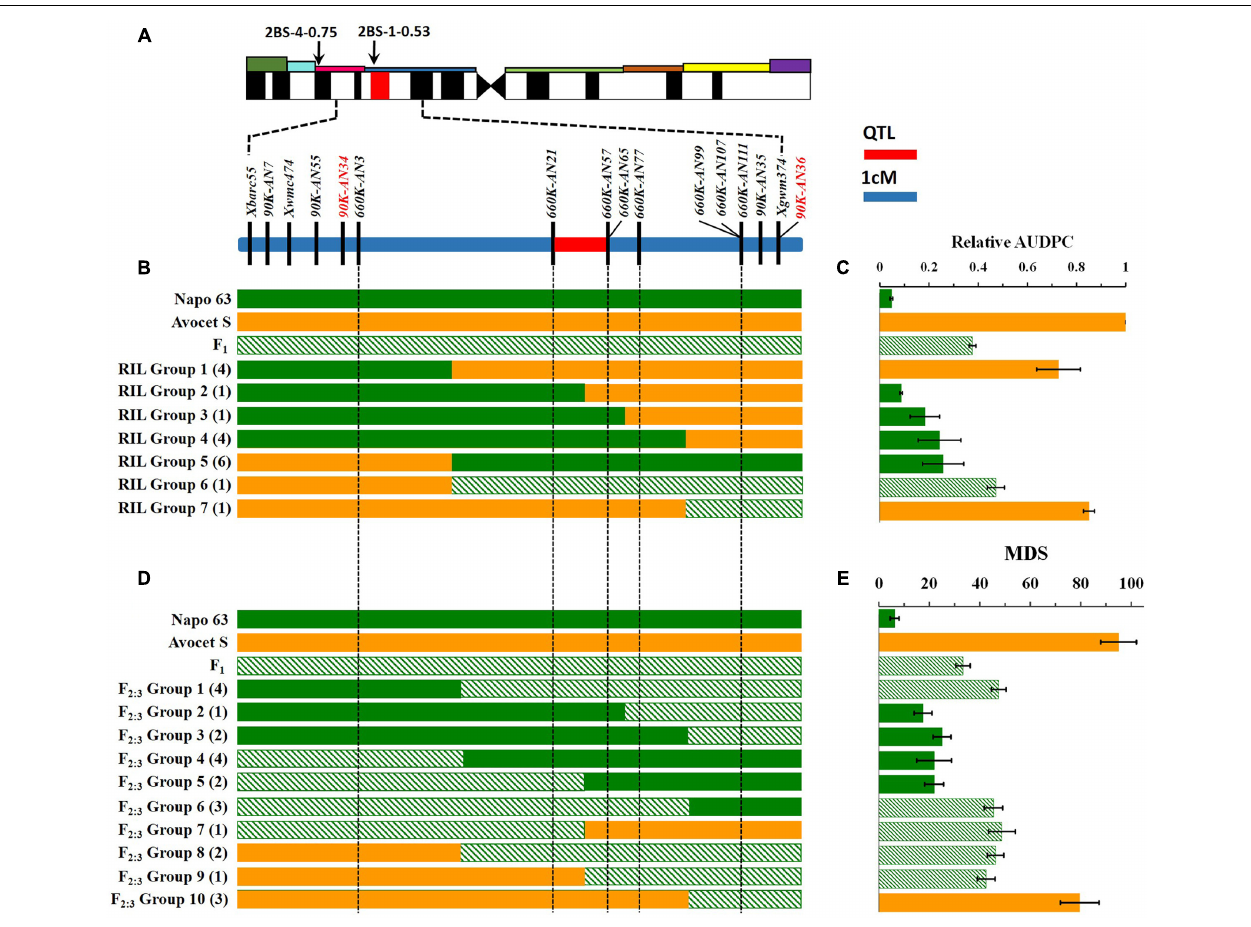
FIGURE 3 | Interval mapping of the QTL region for Qyrnap.nwafu-2BS and association with phenotype. (A) Deletion bin location of Qyrnap.nwafu-2BS in 2BS indicated by SSR markers and linkage map of SNP and SSR markers across the Qyrnap.nwafu-2BS interval. (B) The graphical genotype of in Avocet S × Napo 63 RILs and (D) F 2 : 3 lines are aligned against their response to stripe rust ( C,E , respectively). Recombinants are grouped by adjacent markers, and numbers of lines in each group are indicated in parentheses. Green, orange and slash bars represent homozygous resistant (Napo 63), homozygous susceptible (Avocet S) and heterozygous resistant (F 1 ) genotypes, respectively. Response groups are differentiated as susceptible (orange), moderately resistant (slash) or resistant (green) based on statistical comparison with the parental and F 1 controls. Error bars are SEM. Detailed data are provided in Supplementary Tables S4,